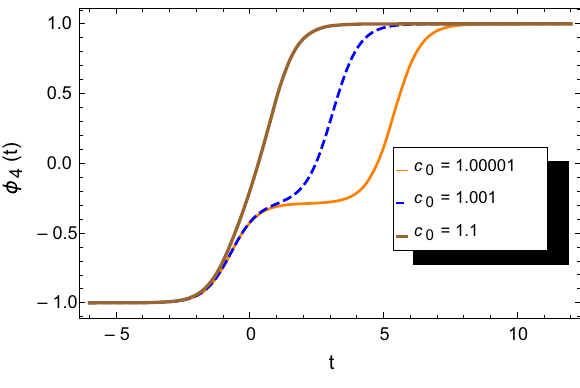
Fig. 4 Profiles of solutions φ 4 ( t ) (Eq. (29)) with λ 3 = 0 . 6